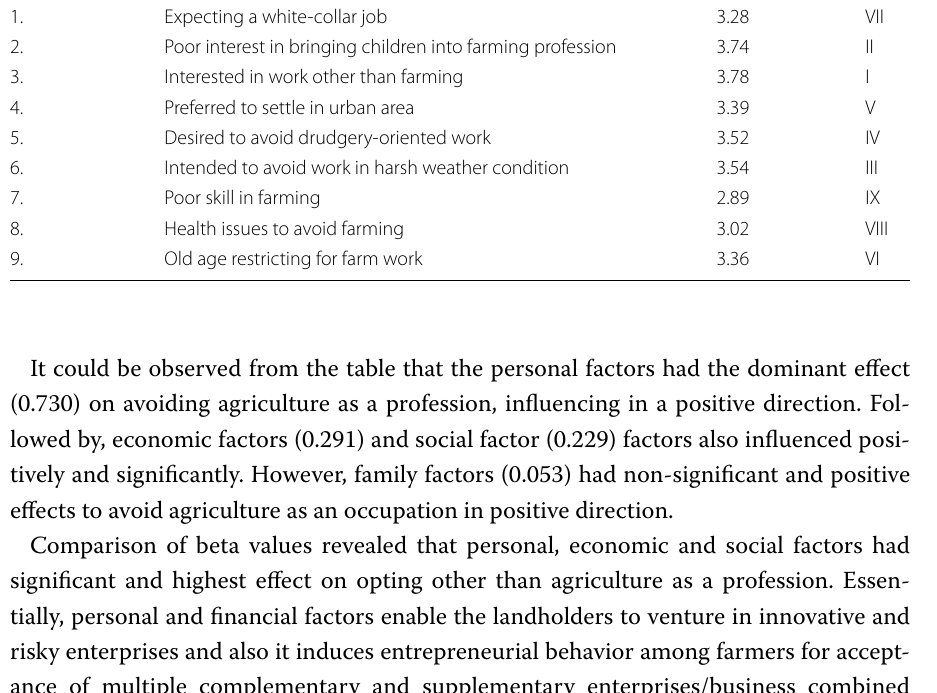
Table 7 Personal factors for avoiding agriculture as a profession ( n Sr.